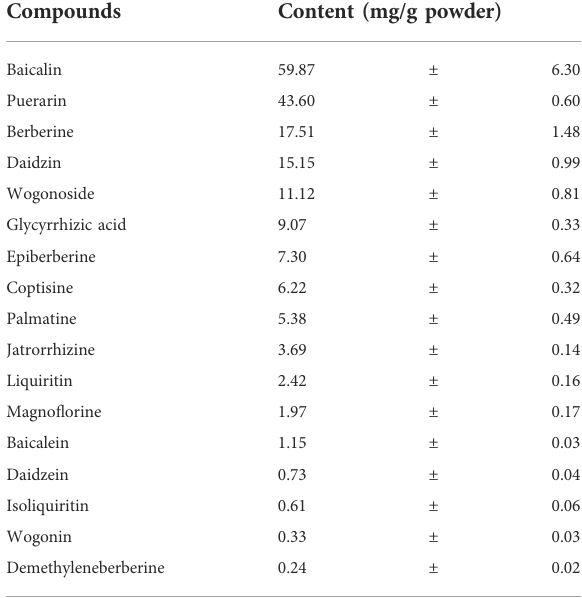
TABLE 2 Contents of 17 constituents in the dried powder of Gegen - Qinlian decoction extract (mean ± SD, n = 3).